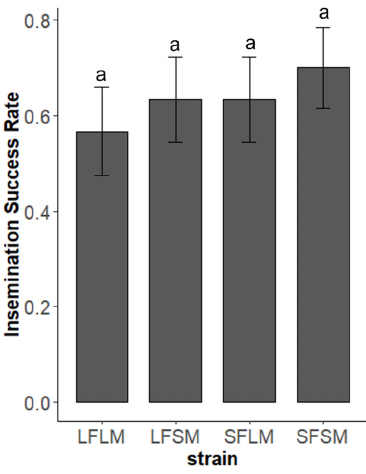
Figure 7. The insemination success rate of female SPWs after copulation in four treatments (LF × LM, LF × SM, SF × LM, SF × SM). Treatments with different letters are significantly different ( p < 0.05) in a generalized linear model. Error Standard errors are shown on the column bars.